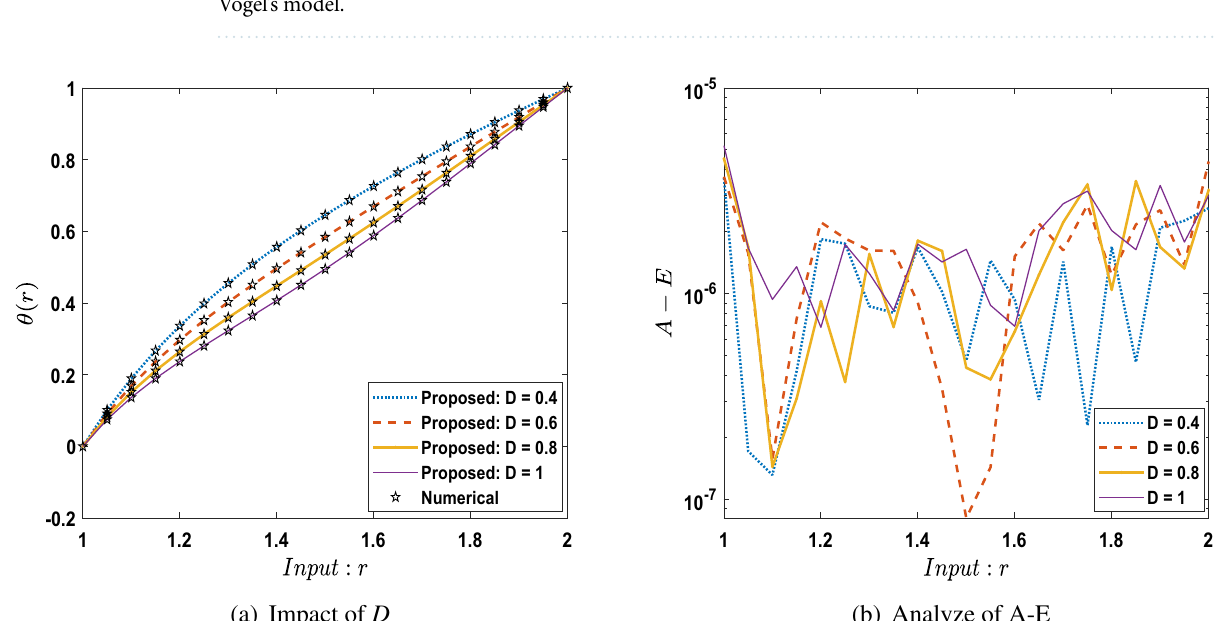
Figure 26. Comparison between suggested LMA-TNN with results of numerical reference for scenario 2 in Vogel’s model.